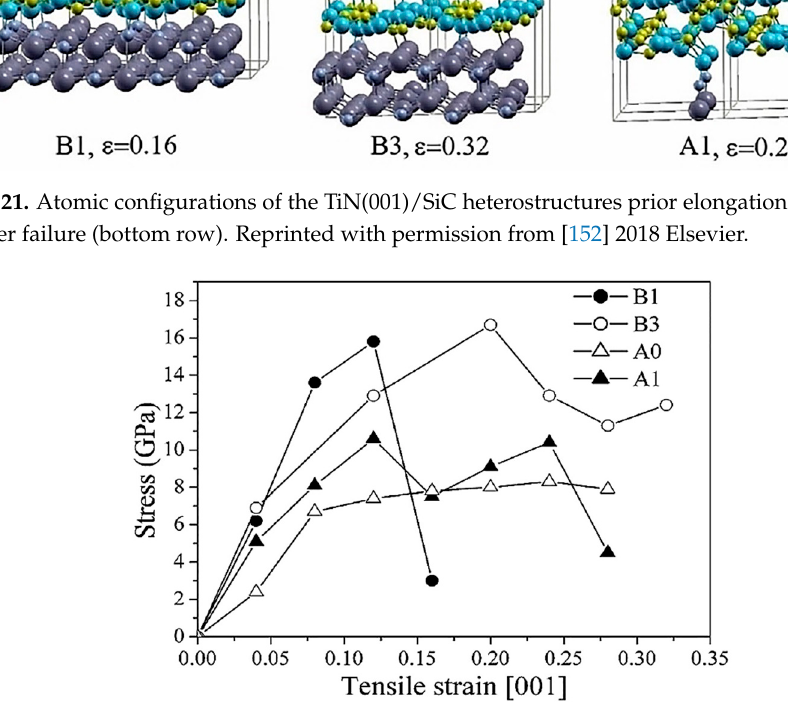
Figure 22. Stress-tensile strain curves of the TiN(001)/SiC heterostructures simulated at different conditions. Reprinted with permission from [152] 2018 Elsevier.